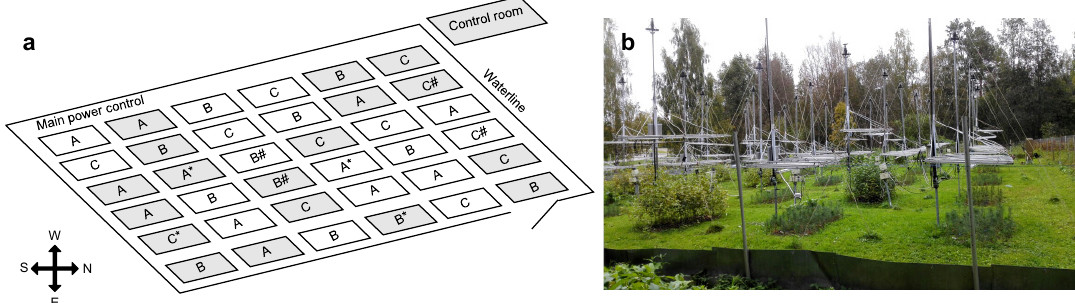
Figure 1. ( a ) Schematic representation of the experimental field. Filled plots (size 0.8 × 2.4 m) represent warming treatment, open plots ambient temperature. A, B and C are Betula pendula , Picea abies and Pinus sylvestris , respectively. # is the air temperature sensor controlling the modulated system, * is equipped with air temperature sensors. ( b ) Photograph of the field seen from the perspective of the control room (photograph by Virpi Virjamo, 2016).